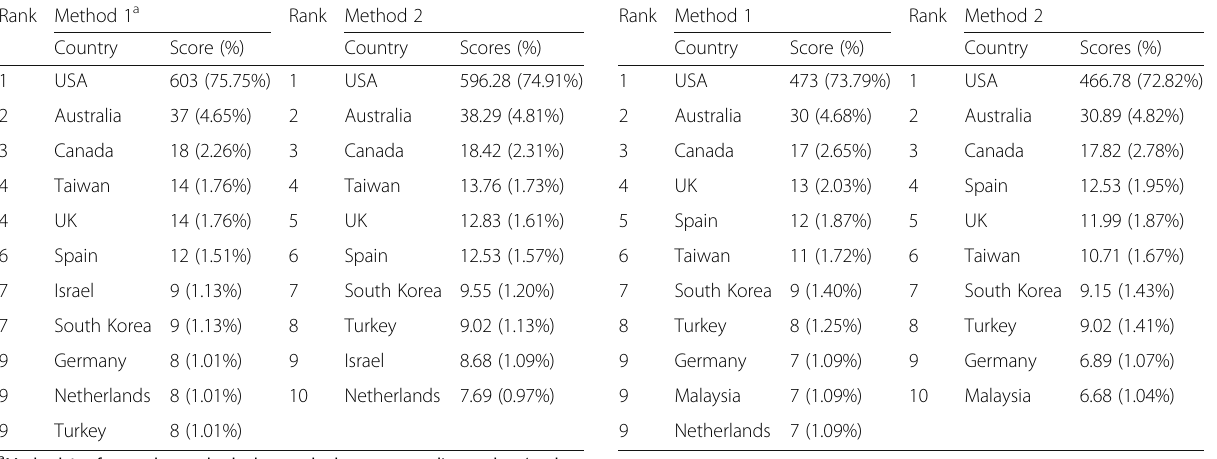
Table 3 Top 10 authorship countries/regions for all 798